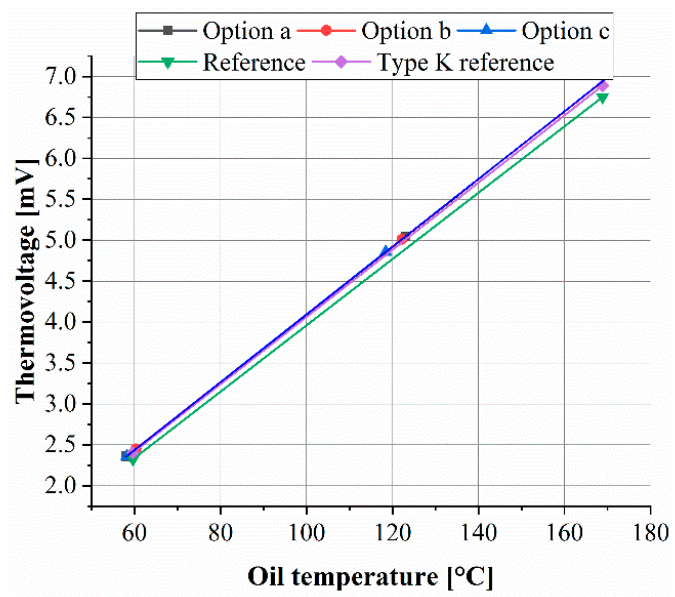
Figure 9. Calibration curve for the Ni / Ni-20Cr thermocouple combined with AlN-1 layers.